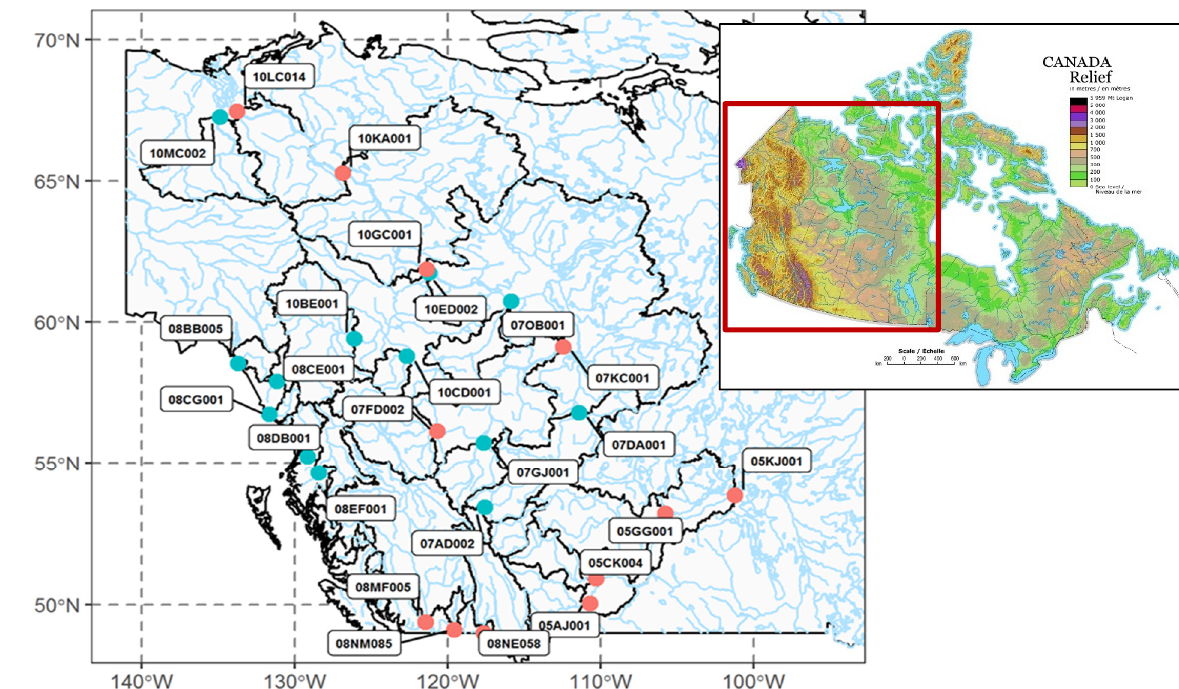
Figure 1. The western Canadian study area including the relief map, the drainage basins and the location and regulation status of hydrometric stations. Red and blue points depict regulated and unregulated stations, respectively (source of the relief map: Natural Resources Canada).